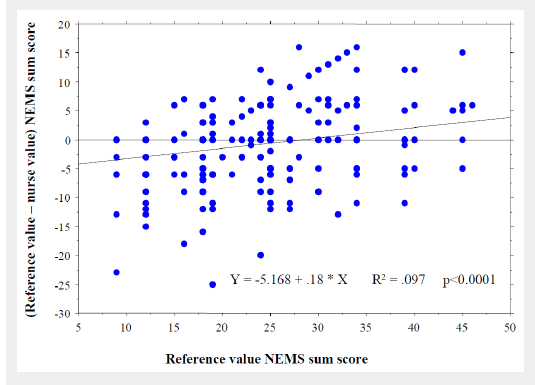
Linear regression between the difference (reference value – nurse value) of the NEMS sum-score and the mean NEMS sum-score [(reference value + nurse value) x 0.5].